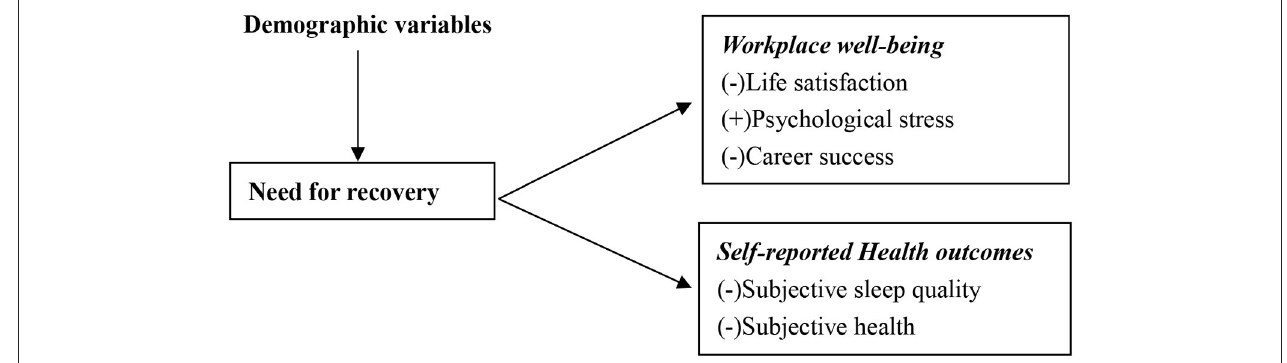
FIGURE 1 | The conceptual framework of